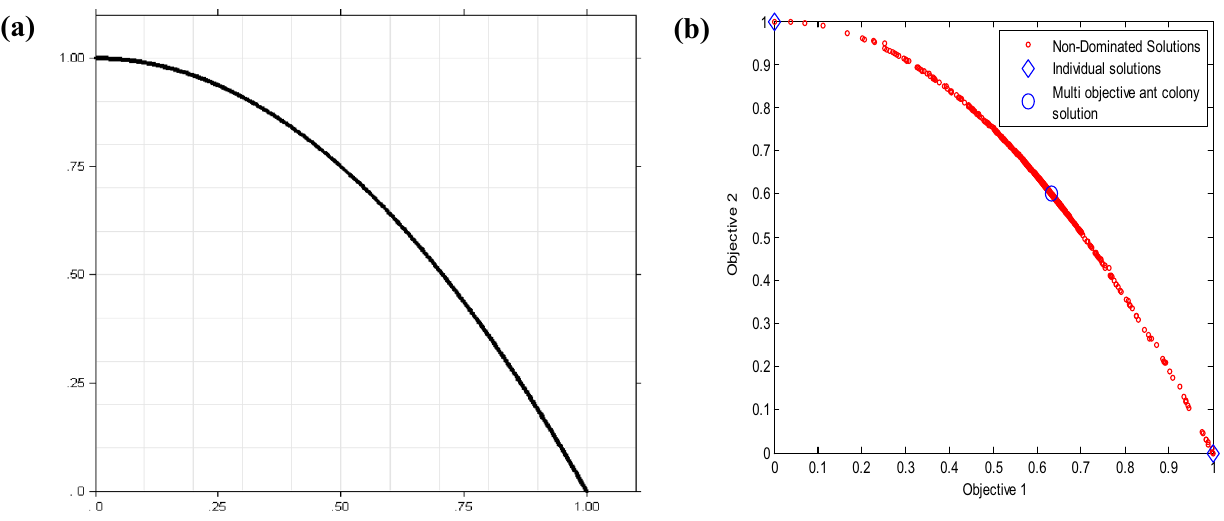
Fig. 4 Pareto front of ZDT2 a standard Pareto front (Deb 2010) and b obtained by multiobjective ant colony optimization